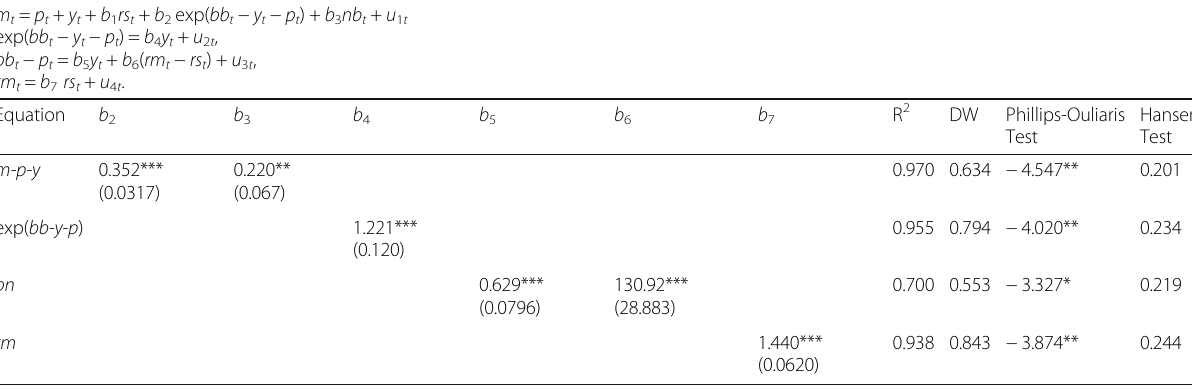
Table 2 Cointegration test and estimates, M1, real income, price level, interest rates, and bank balance sheet total, Switzerland, 1851 – 1906